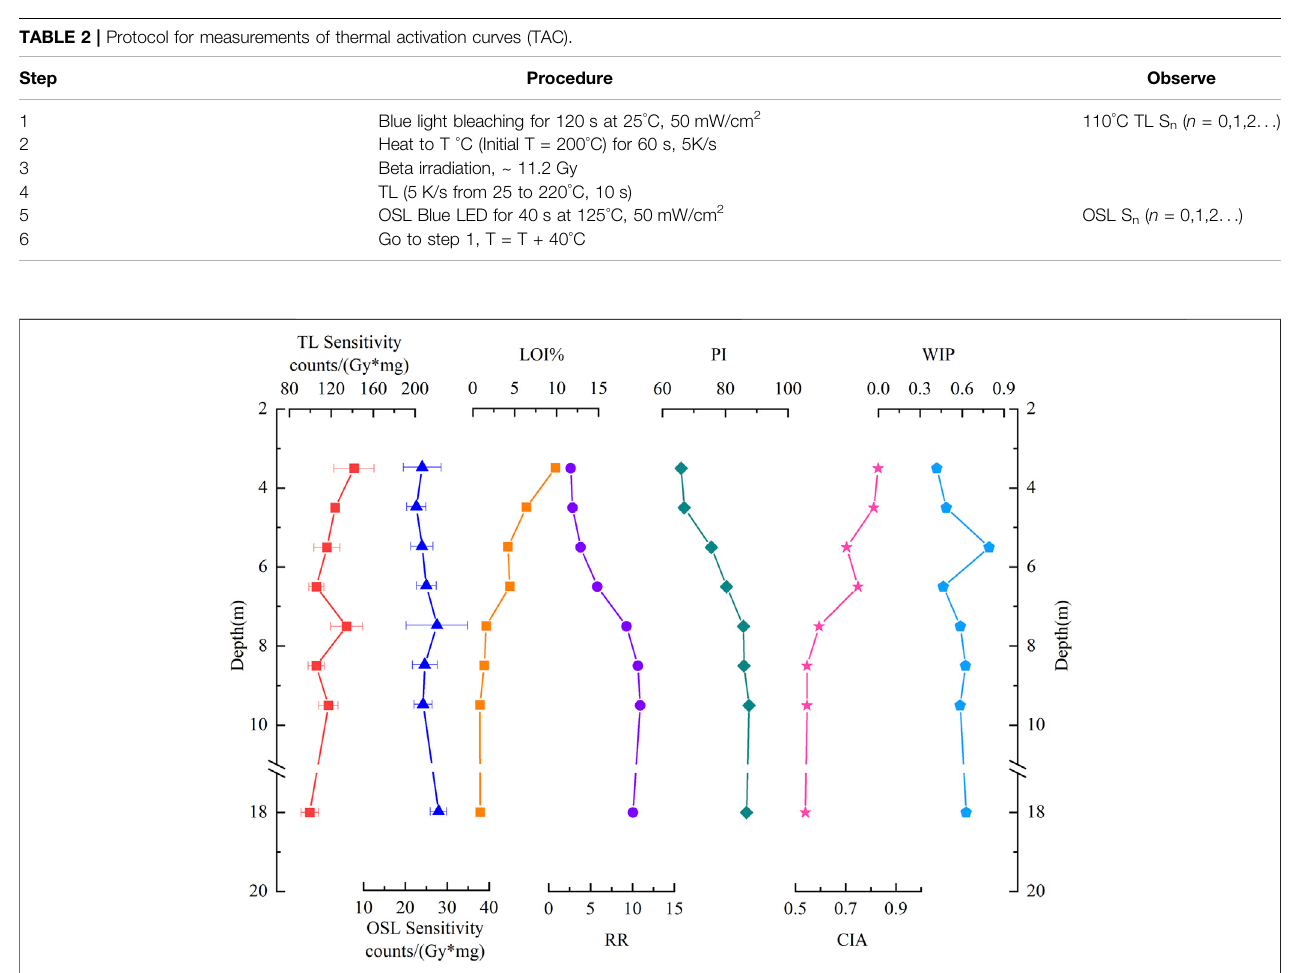
Frontiers in Earth Science |